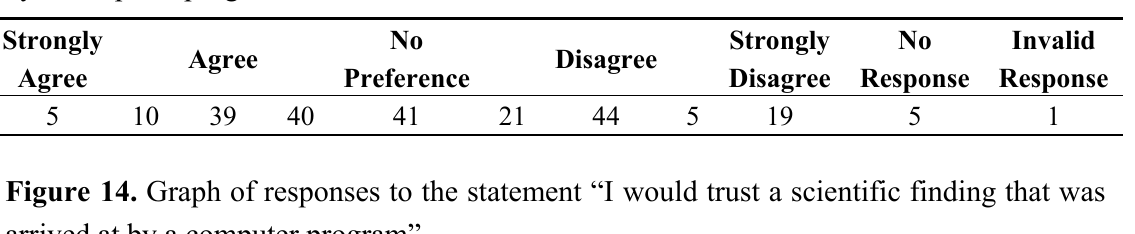
Table 13. Responses to the statement “I would trust a scientific finding that was arrived at by a computer program”.